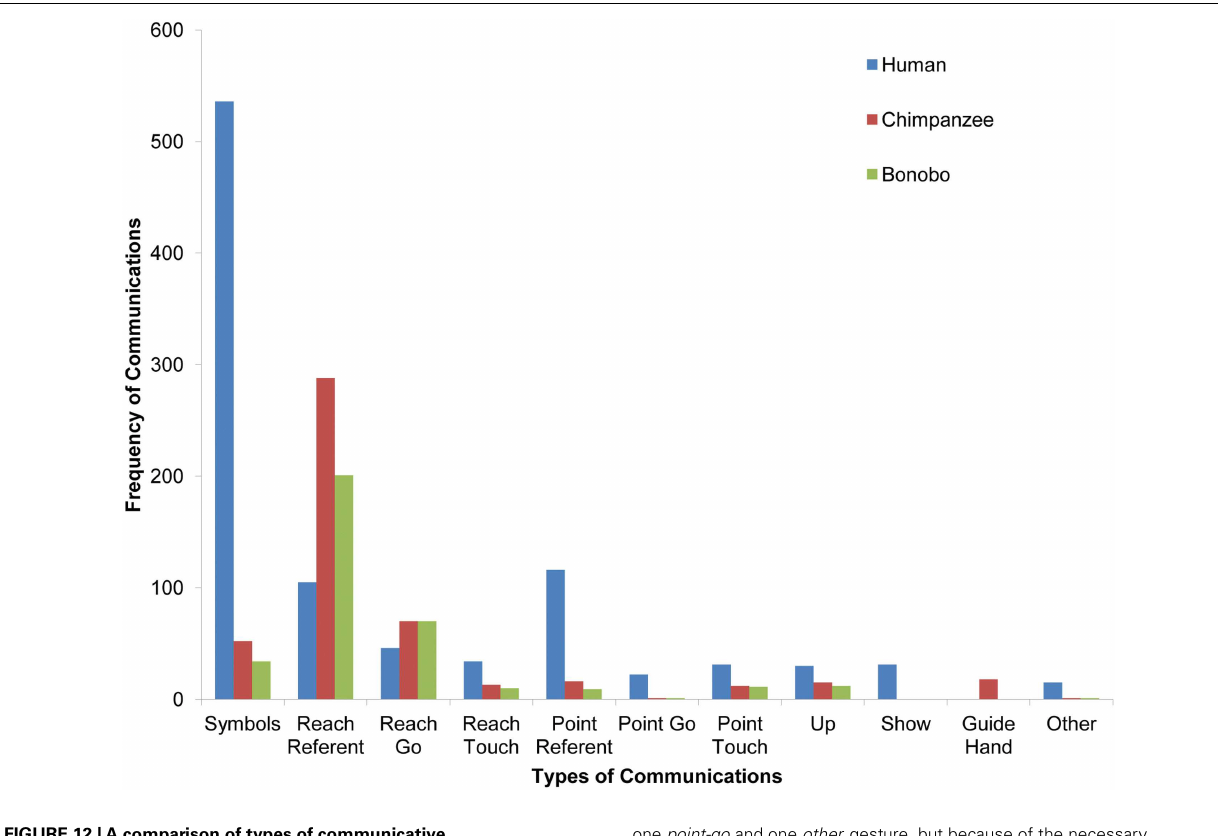
one point-go and one other gesture, but because of the necessary scale of the graphs to capture high frequency categories, they are not